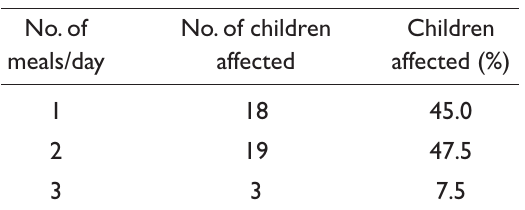
Table 1. Number of Meals Received by the Children on ART Per Day According to Primary Care